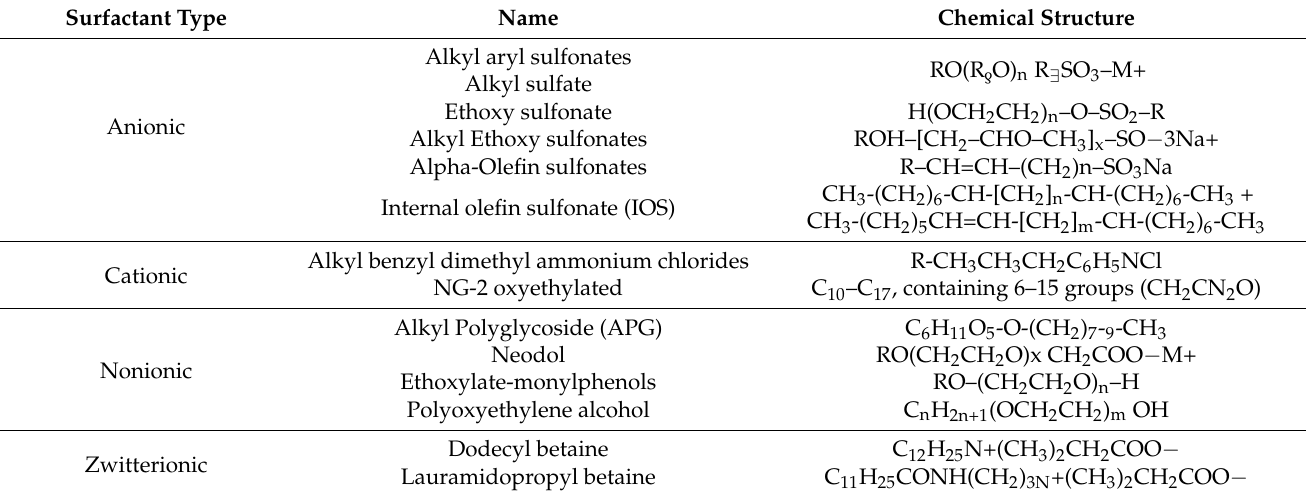
Table 1. The types and chemical structures of the surfactants used in EOR methods [18,37]. Surfactant Type Name Chemical Structure